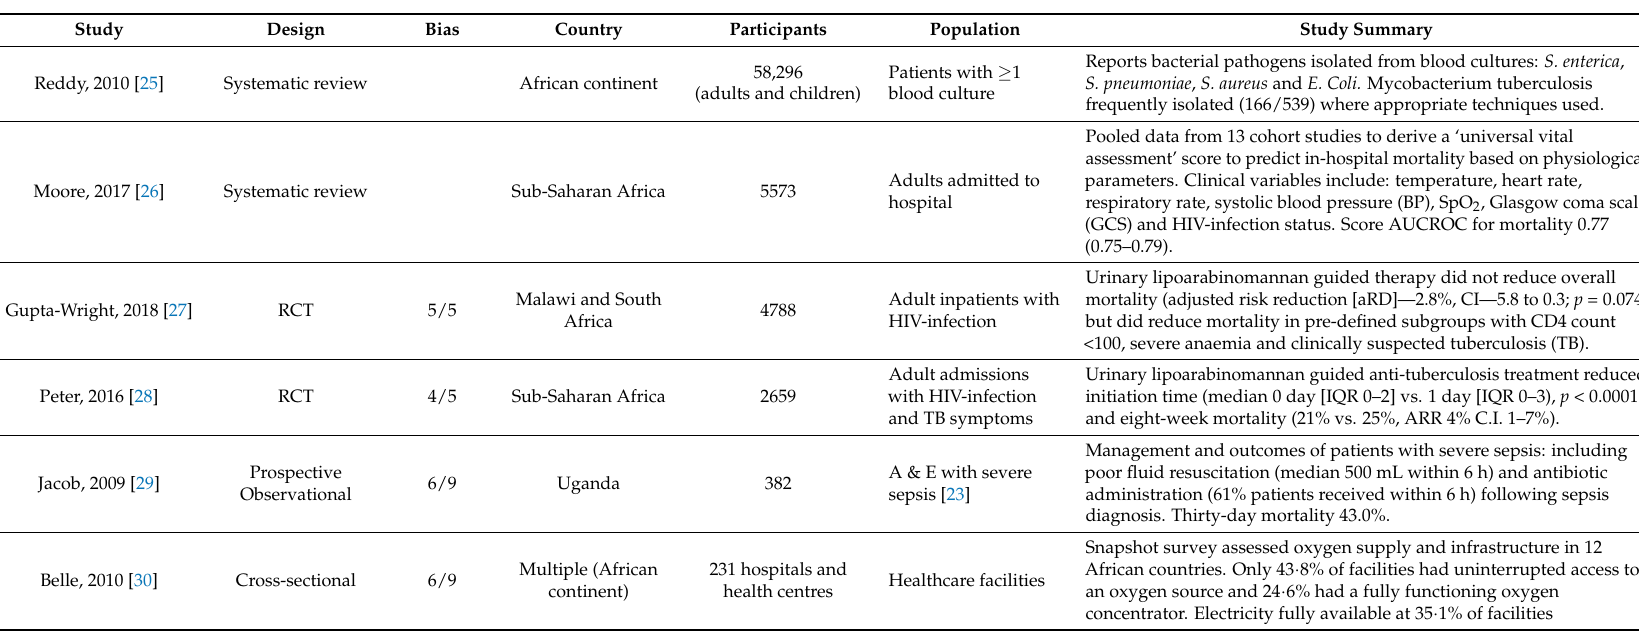
Table 2. Additional studies that did not meet full inclusion criteria but examined components of early sepsis management included in the